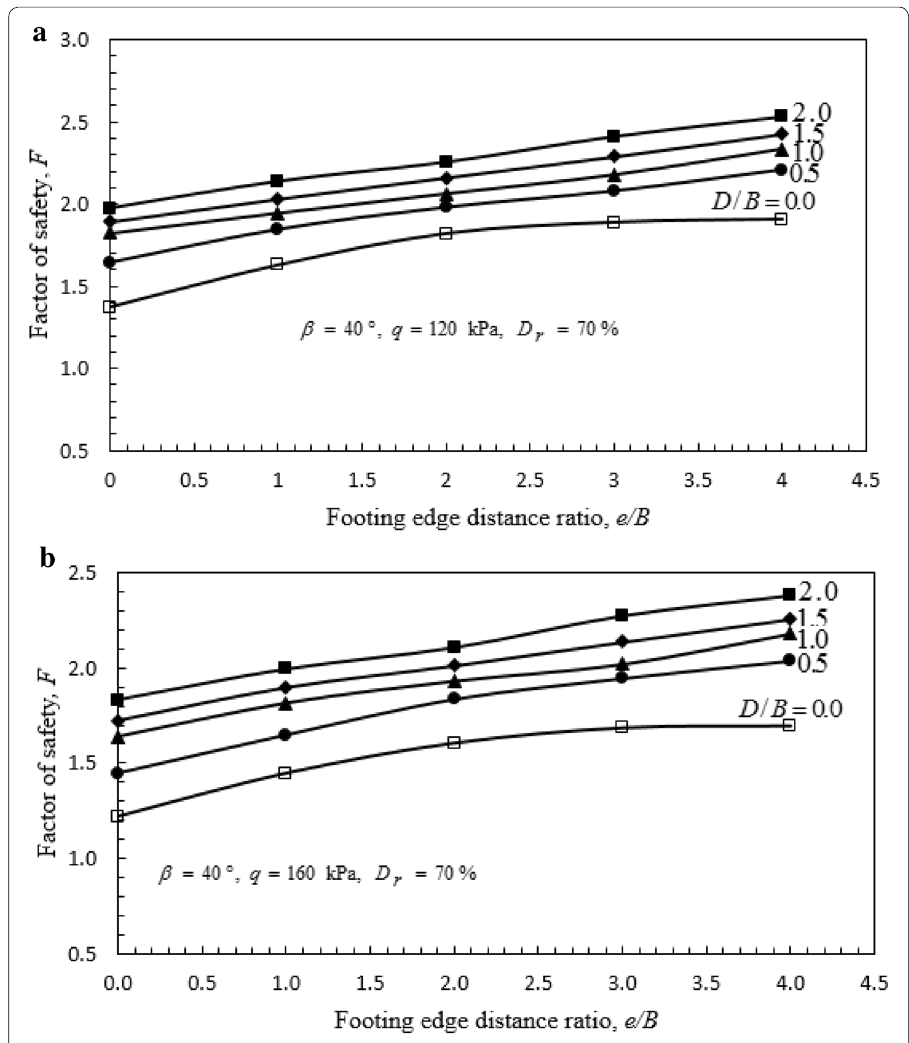
Fig. 8 Variation of factor of safety, F , with edge distance ratio, e / B : a q = 120kPa , b q =